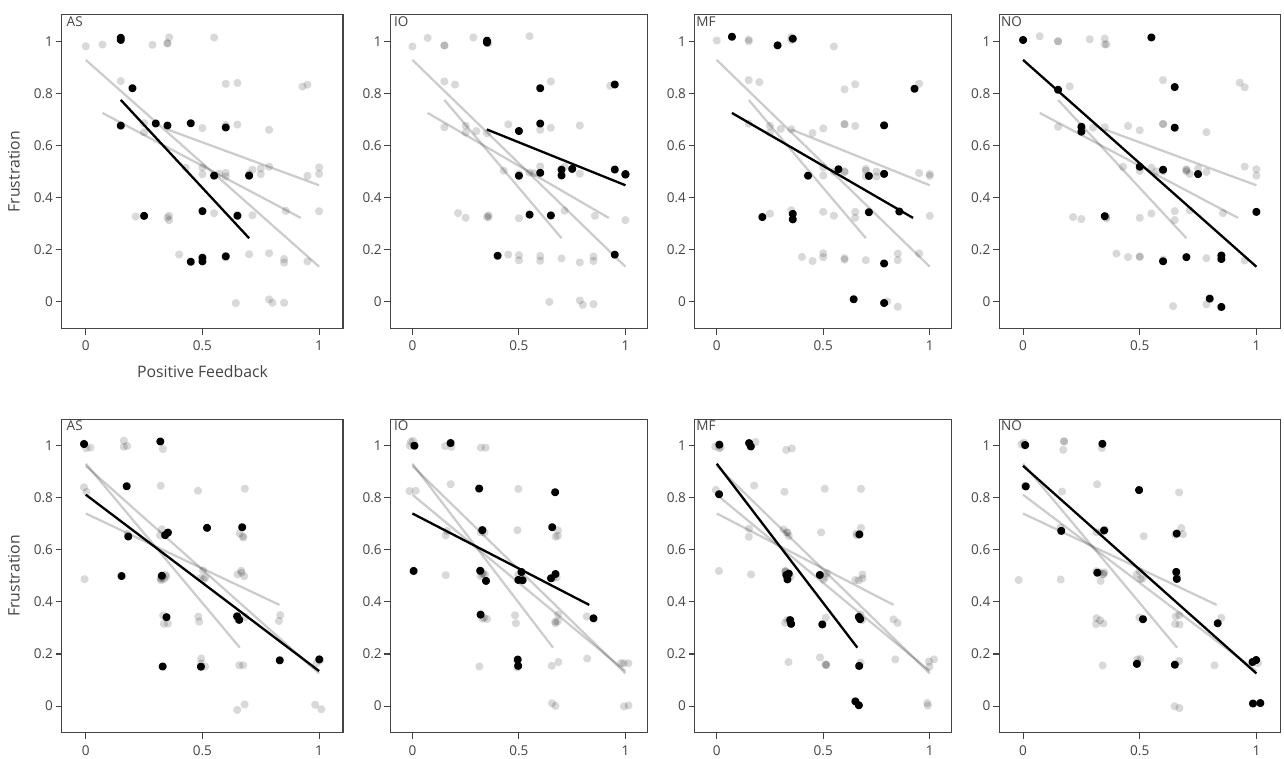
Figure 5. The relationship between perceived control and positive feedback is shown in the top row of each of the four conditions, while the relationship between frustration and positive feedback is shown in the middle row. In the bottom row, the relationship between frustration and perceived control is shown. AS: augmented success, IO: input override, MF: mitigated failure, and NO: normal condition without PAM help. Each data point represents the rating of a single